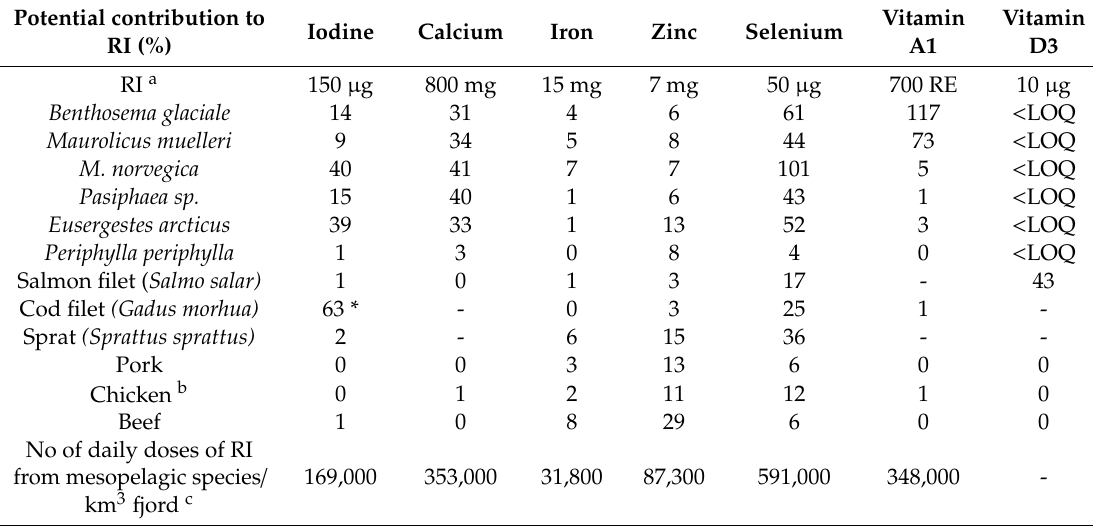
Table 5. Potential contribution (%) of selected micronutrients to recommended intake (RI) in women from a serving of 50 g mesopelagic species in comparison to cod, salmon, sprat, beef, pork and chicken, and the potential doses of daily RI for women per km 3